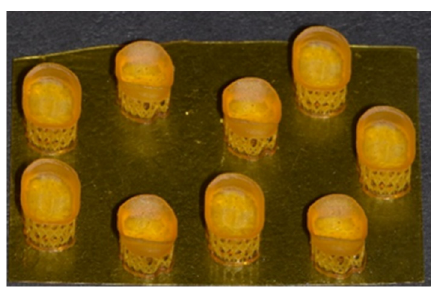
Figure 4. 3D resin patterns for casted frameworks.